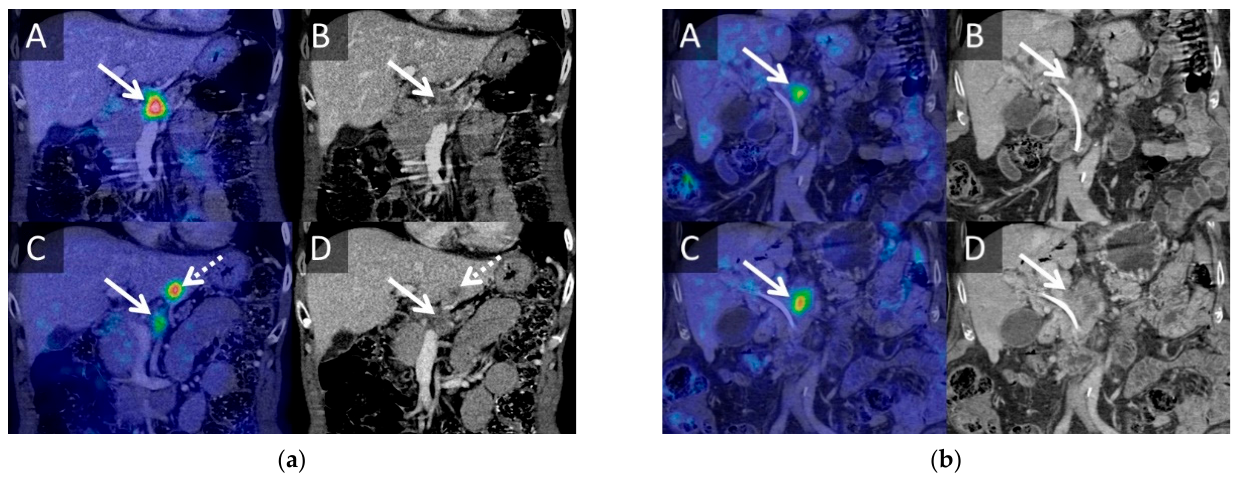
Figure 1. Representative 18 FDG PET/CT images before and after IRE. ( a ) Sixty-one-year-old female with a T4 tumor in the head/body of the pancreas without nodal metastases. The patient was treated with three different chemotherapy regimens (FOLFIRINOX, XELOX, and gemcitabine) prior to inclusion (eight series in total). The patient was referred to IRE due to progression on chemotherapy. PET/CT images were performed before IRE ( A , B ) and 3 months after IRE ( C , D ). The patient had regression of SUVmax (9 -> 3.5 SUV bw ), MTV (9 -> 1.86 cm 3 ), TLG (37.51 -> 5.41 SUV bw cm 3 ), and tumor size (23 -> 20 mm) at the primary tumor (solid arrow) but developed a PET-avid metastasis in liver segment III (dotted arrow). The patient received seven additional series of chemotherapy (XELOX and gemcitabine) after the 3-month scan and survived for 21 months after IRE ablation. ( b ) Seventy-seven-year-old male with a T4 tumor in the head/body of the pancreas with local nodal metastases. The patient was treated with six series of GEMCAP chemotherapy prior to inclusion. The patient was referred to IRE treatment due to progression on chemotherapy. PET/CT images were performed prior to IRE ( A , B ) and 3 months after IRE ( C , D ). The patient had increased SUVmax (5.27 -> 6.04 SUV bw ), MTV (5.09 -> 10.66 cm 3 ), TLG (16.31 -> 34.73 SUV bw cm 3 ), and tumor size (25 -> 33 mm) of the primary tumor (arrow) after IRE ablation. The patient did not receive any chemotherapy after IRE ablation, because of intolerance. The patient survived for 10 months after IRE ablation.